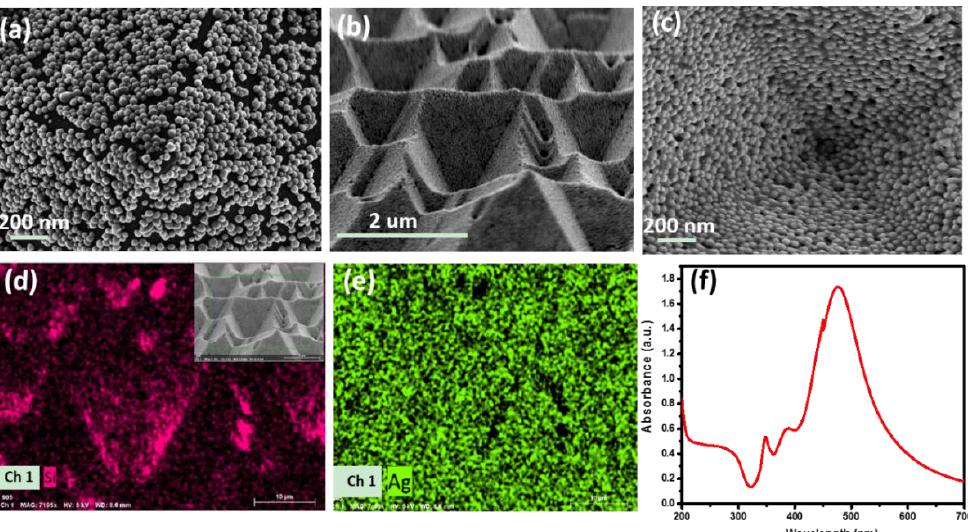
Figure 2. ( a ) Scanning electron microscopy (SEM) image of AgNPs deposited on the P-Si substrate; ( b ) and ( c ) are SEM images of the P–AgNPs@PMMA substrate in different magnification; ( d ) and ( e ) energy dispersive spectrometer (EDS) mapping of the P–AgNPs@ PMMA flexible substrates; ( f ) UV–vis absorption spectra showing the SPR peak of the AgNPs at ~476 nm.